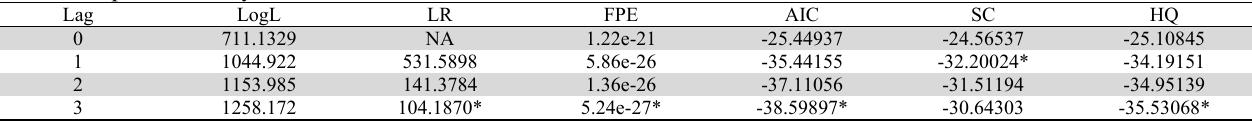
Exogenous variables: C LPW